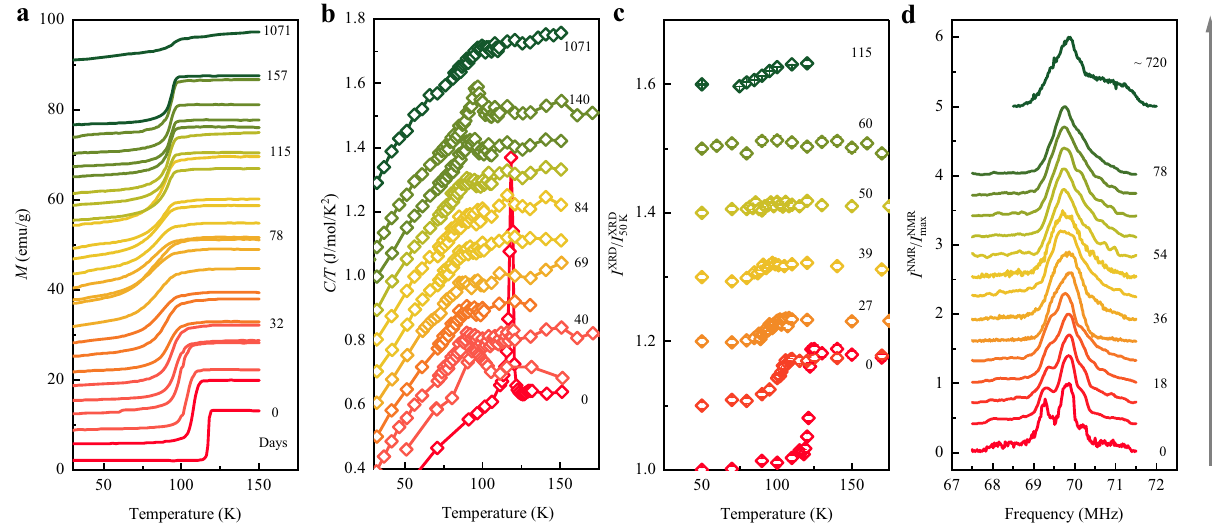
Fig. 1 Physical measurements for Fe 3 O 4 nanoparticles during up to 1071 days of oxidation. a Magnetization curves as a function of temperature, with successive data offset by 3.0 emu/g. The magnetization was measured at H = 100 Oe. b C / T ( C = heat capacity) with an offset of 0.1 J/mol/K 2 . c The normalized amplitude of the (440) XRD peak, I XRD = I XRD , offset by 0.1 units, determined from fi ts of a Gaussian function to the (440) peak. The error bars 50K are de fi ned as the standard deviation (SD) based on the fi tting results of the XRD peak. d NMR spectra measured at T = 80 K with intensity I NMR = I NMR normalized to the maximum of each spectrum and offset by 0.3 units. Oxidation times in days are denoted on each